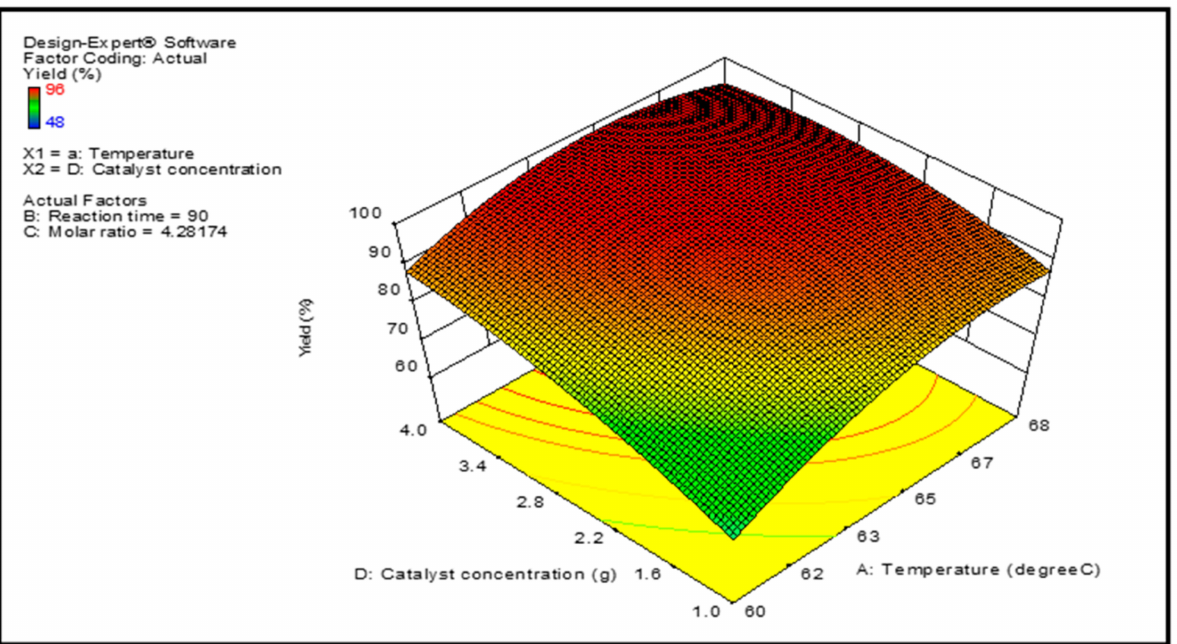
Figure 8. Projected biodiesel production against reaction time and catalysts concentration on a response surface 3D graphic.